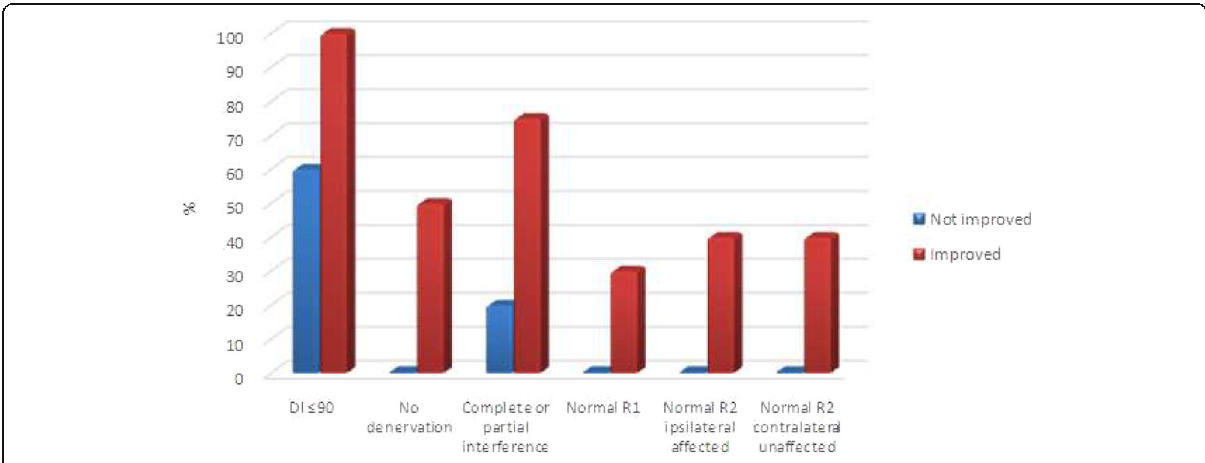
Fig. 6 Relation between SBS at follow-up visit (30th day) and different parameters of the studied patients